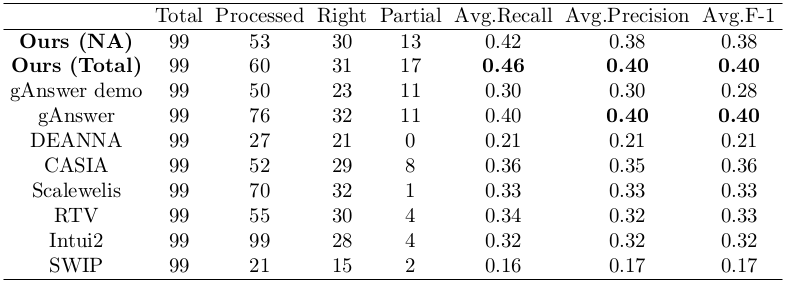
Table from the paper: A Graph Traversal Based Approach to Answer Non-Aggregation Questions Over DBpedia
Table text:
Total Processed Right Partial Avg.Recall Avg.Precision Avg.F-1
Ours(NA)
99
53
30
13
0.42
0.38
0.38
Ours(Total)
99
60
31
17
0.46
0.40
0.40
gAnswerdemo
99
50
23
11
0.30
0.30
0.28
gAnswer
99
76
32
11
0.40
0.40
0.40
DEANNA
99
27
21
0
0.21
0.21
0.21
CASIA
99
52
29
8
0.36
0.35
0.36
Scalewelis
99
70
32
1
0.33
0.33
0.33
RTV
99
55
30
4
0.34
0.32
0.33
Intui2
99
99
28
4
0.32
0.32
0.32
SWIP
99
21
15
2
0.16
0.17
0.17